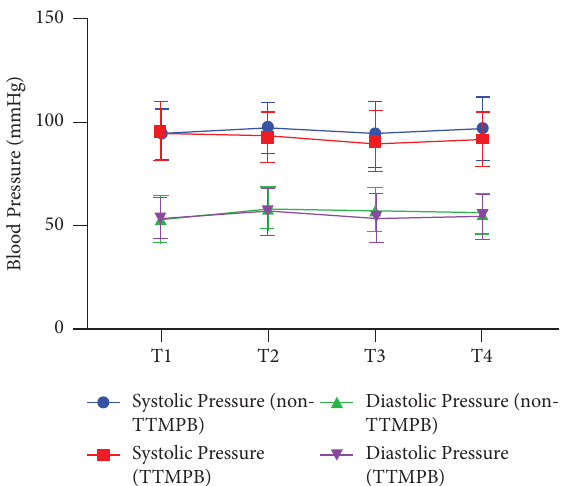
Figure 2: Blood pressure at diferent time points. T1, 10min before TTMPB;T2, skin incision;T3, 1h after surgery; T4, end of surgery. For systolic pressure: p � 0.034 over time change, p � 0.063 between the two groups, p � 0.549 for interaction; for diastolic pressure: p � 0.018 over time change, p � 0.065 between the two groups, p � 0.915 for interaction; TTMPB: transversus thoracis muscle plane